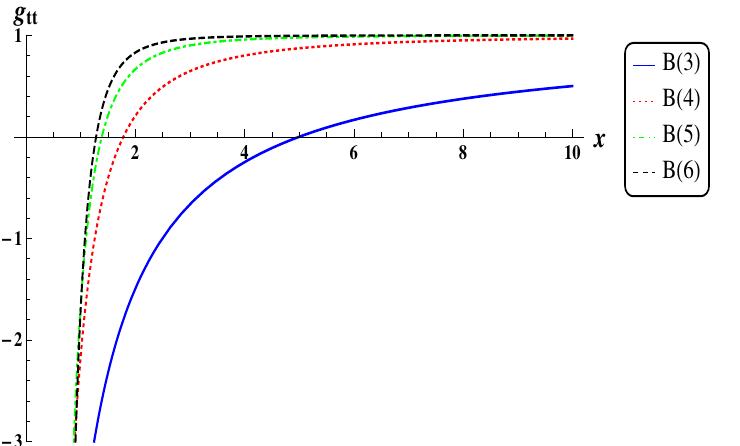
Figure 1. The g tt component for α = 1.5 and η = 2.5. The number in parentheses is the spatial dimension d , with this extra explanation that in units where c = G = ¯ h = 1, these values for α and η are